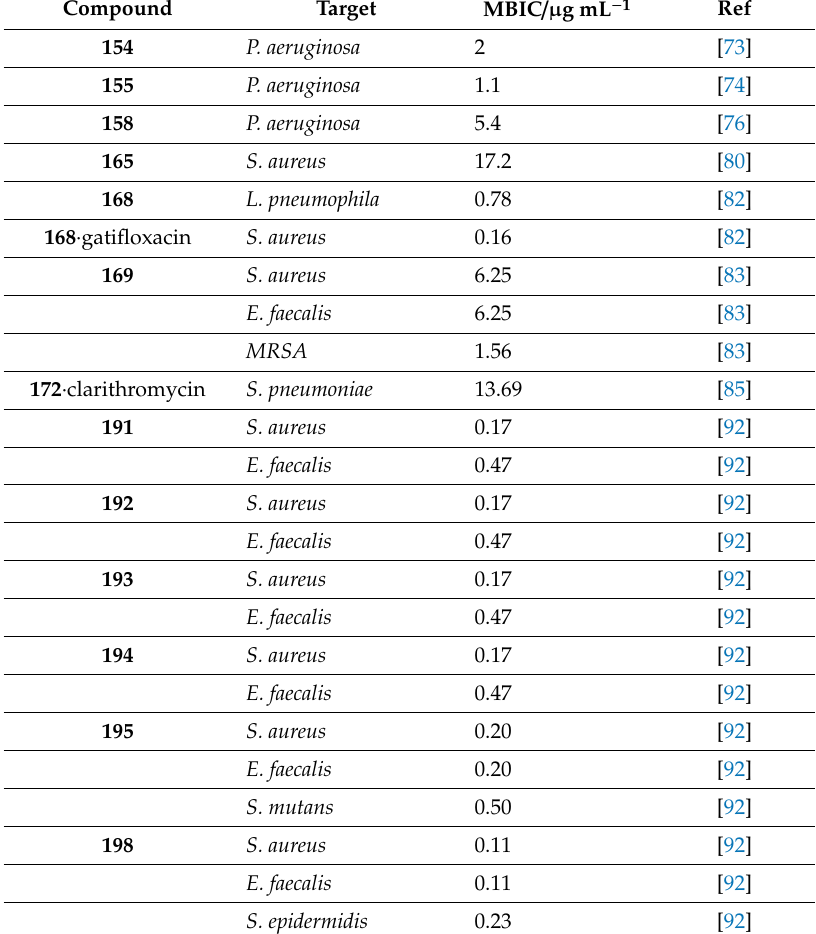
Table 3. Summary of macrocycles demonstrating significant biofilm inhibition.